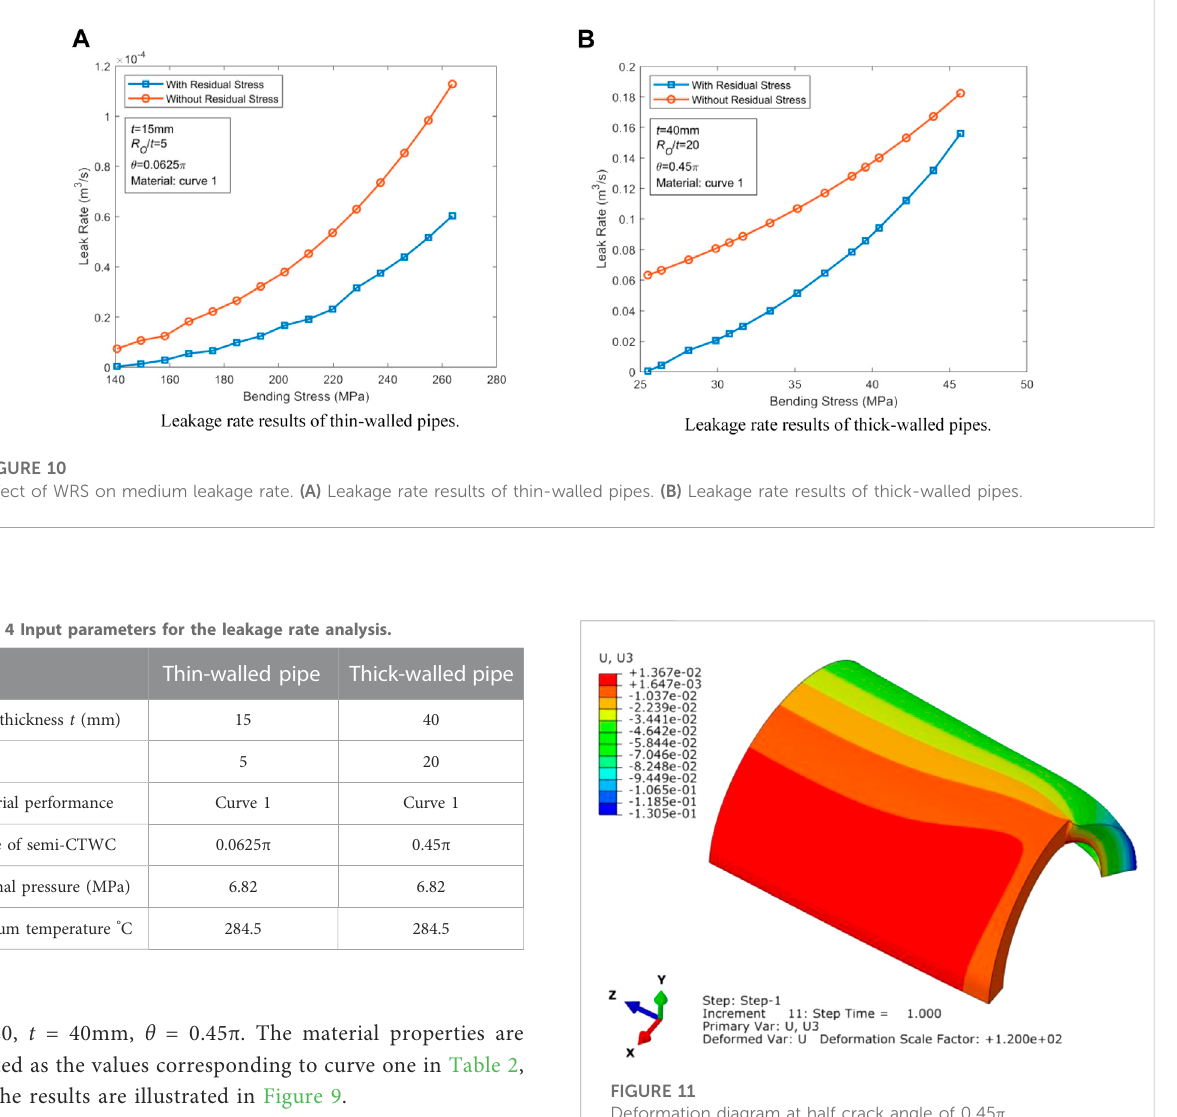
FIGURE 11 Deformation diagram at half crack angle of 0.45 π